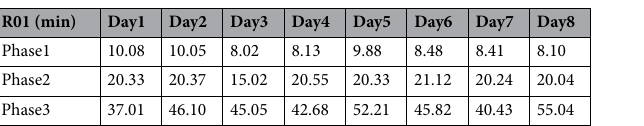
Table 1. Duration in minutes of the different phases, rat